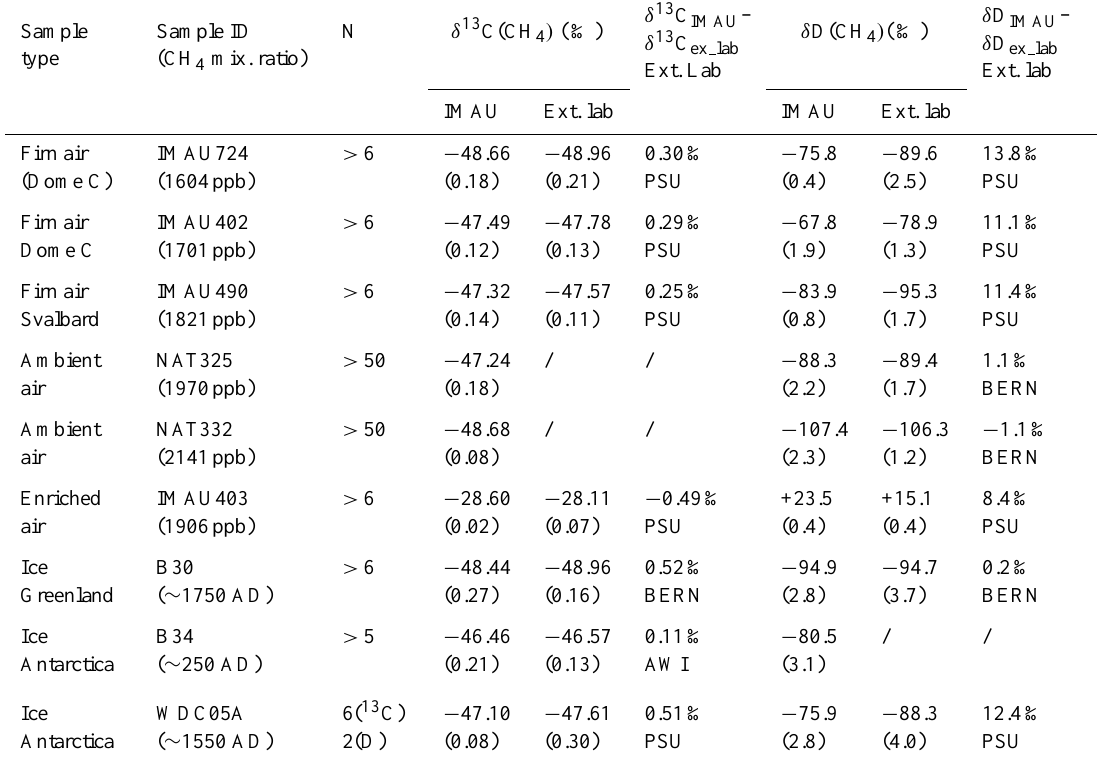
Table 3. Intercomparison of measurements made at IMAU with the new system and at other labs for air samples (six first lines) and ice samples (three last lines). 1 sigma standard deviations from N-measurements are presented between brackets. All data are referenced to V-SMOW for δ D(CH 4 ) and V-PDB for δ 13 C(CH 4 )